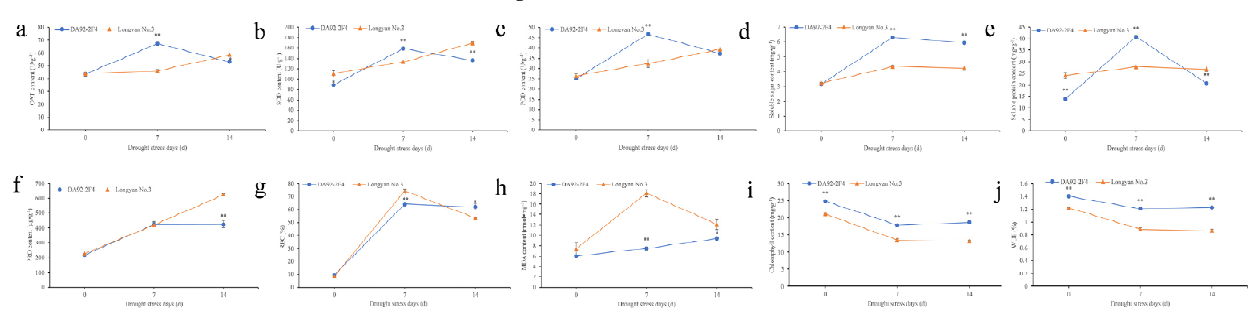
Figure 1. Physiological changes of Avena sativa seedlings with different drought resistance: ( a ) catalase content; ( b ) superoxide dismutase content; ( c ) peroxidase content; ( d ) soluble sugar content; ( e ) soluble protein content; ( f ) proline content; ( g ) relative electric conductivity; ( h ) malondialdehyde content; ( i ) chlorophyll content, and ( j ) water use efficiency. Values are expressed as mean ± SD. Differences were assessed by ANOVA and denoted as follows: * p < 0.05; ** p < 0.01 as compared between two groups.